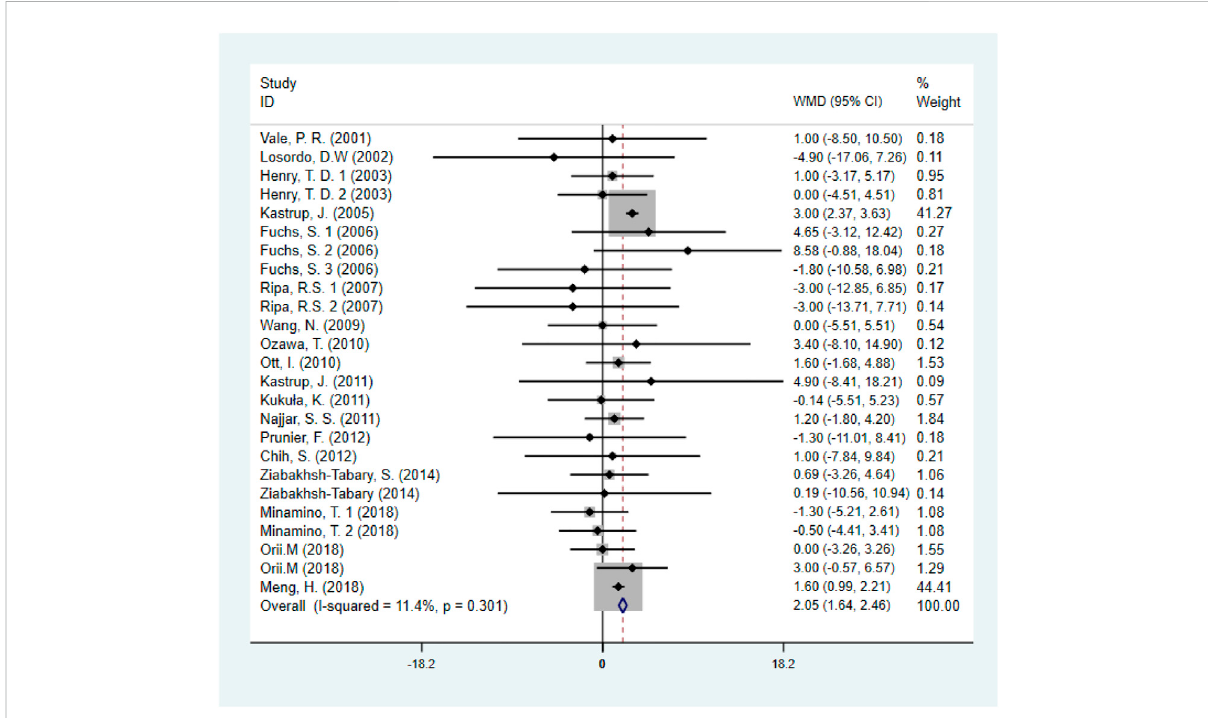
FIGURE 6 Forest plot for LVEF, GF vs. control. LVEF, left ventricular ejection fraction; RR, relative risk; CI, con fi dence interval; ID, identi fi cation.